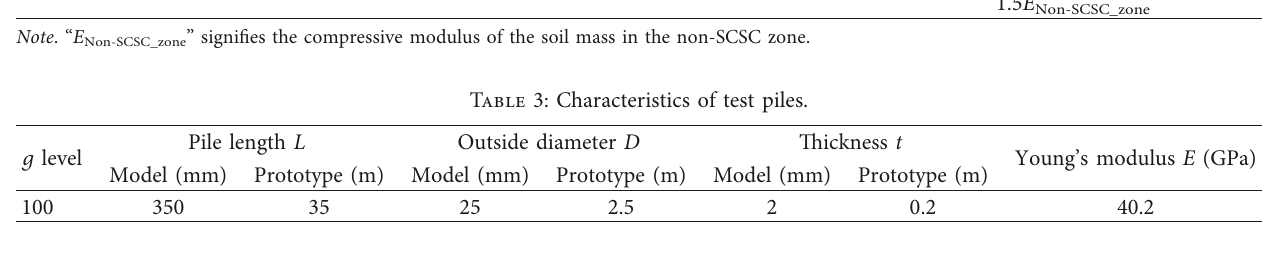
Table 4: Characteristics of steel